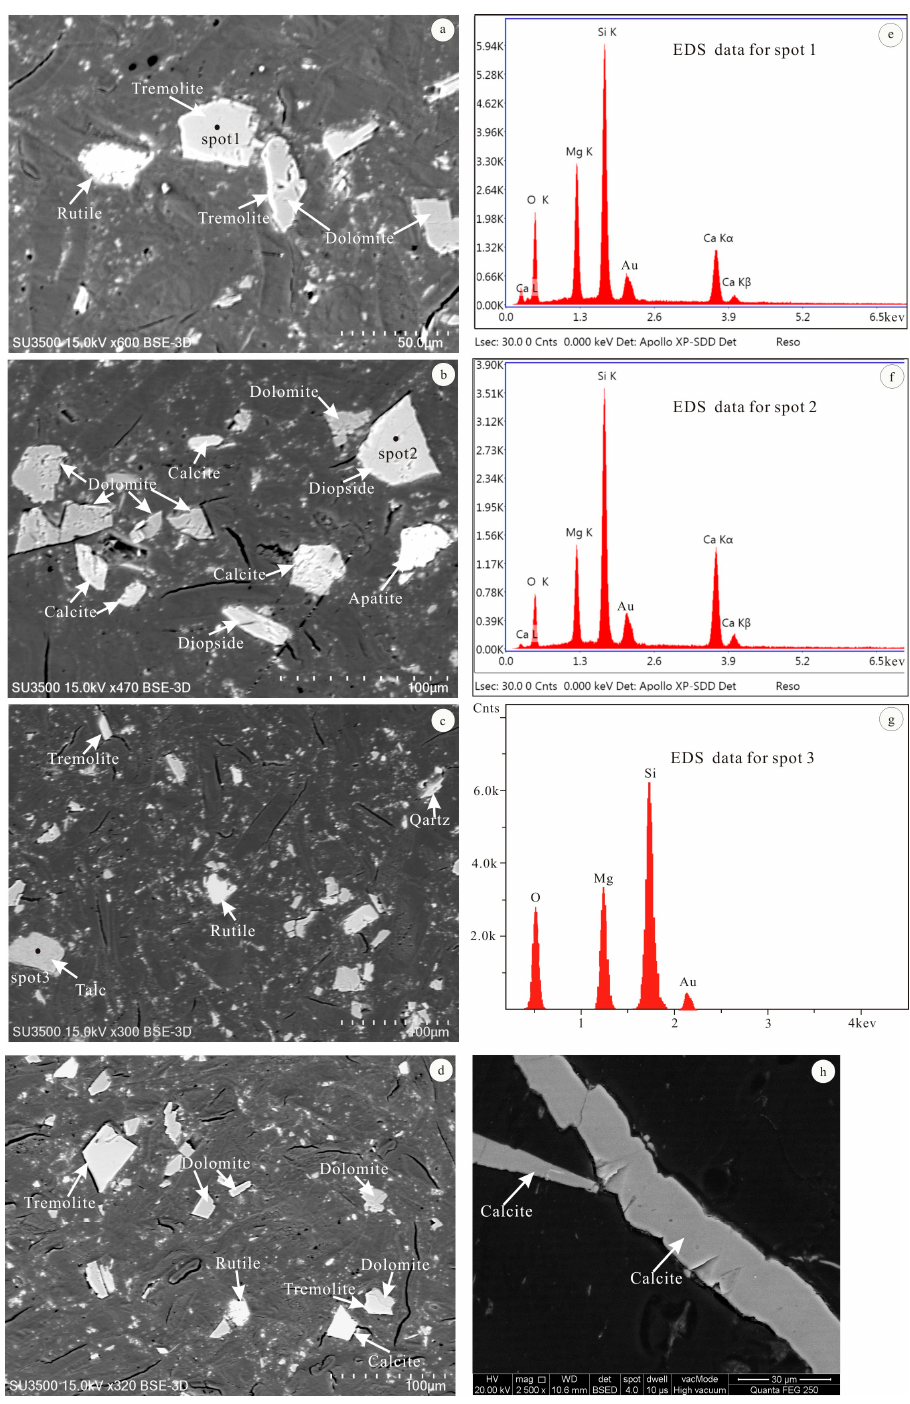
Figure 7. SEM back-scattered electron images of carbonate minerals, rutile, apatite, tremolite, diopside, and talc in 12U and 12L Coals. ( a – d ), cleat-filling calcite, dolomite, tremolite, diopside and talc in 12L Coal; ( e – g ) EDS data for tremolite, diopside, and talc; and ( h ) fracturing-filling calcite in sample 12U-1.